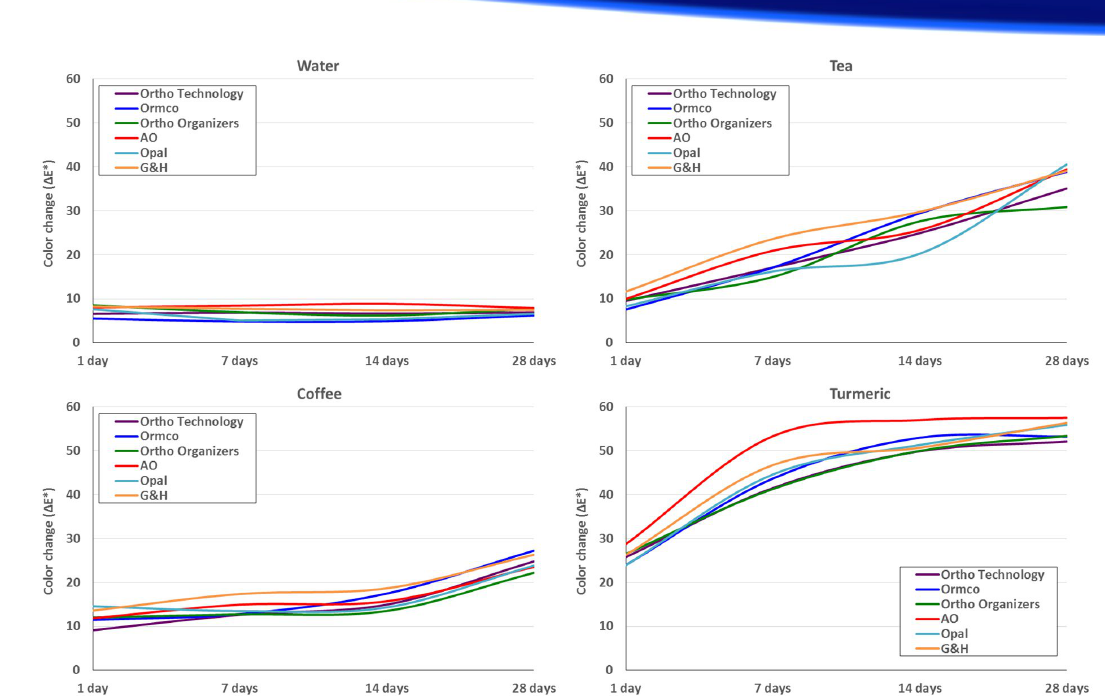
Figure 2: Color changes of elastomeric chains (Ortho Technology, Ormco, Ortho Organizer, AO, Opal and G&H) after immersion in water, tea, coffee, and turmeric.